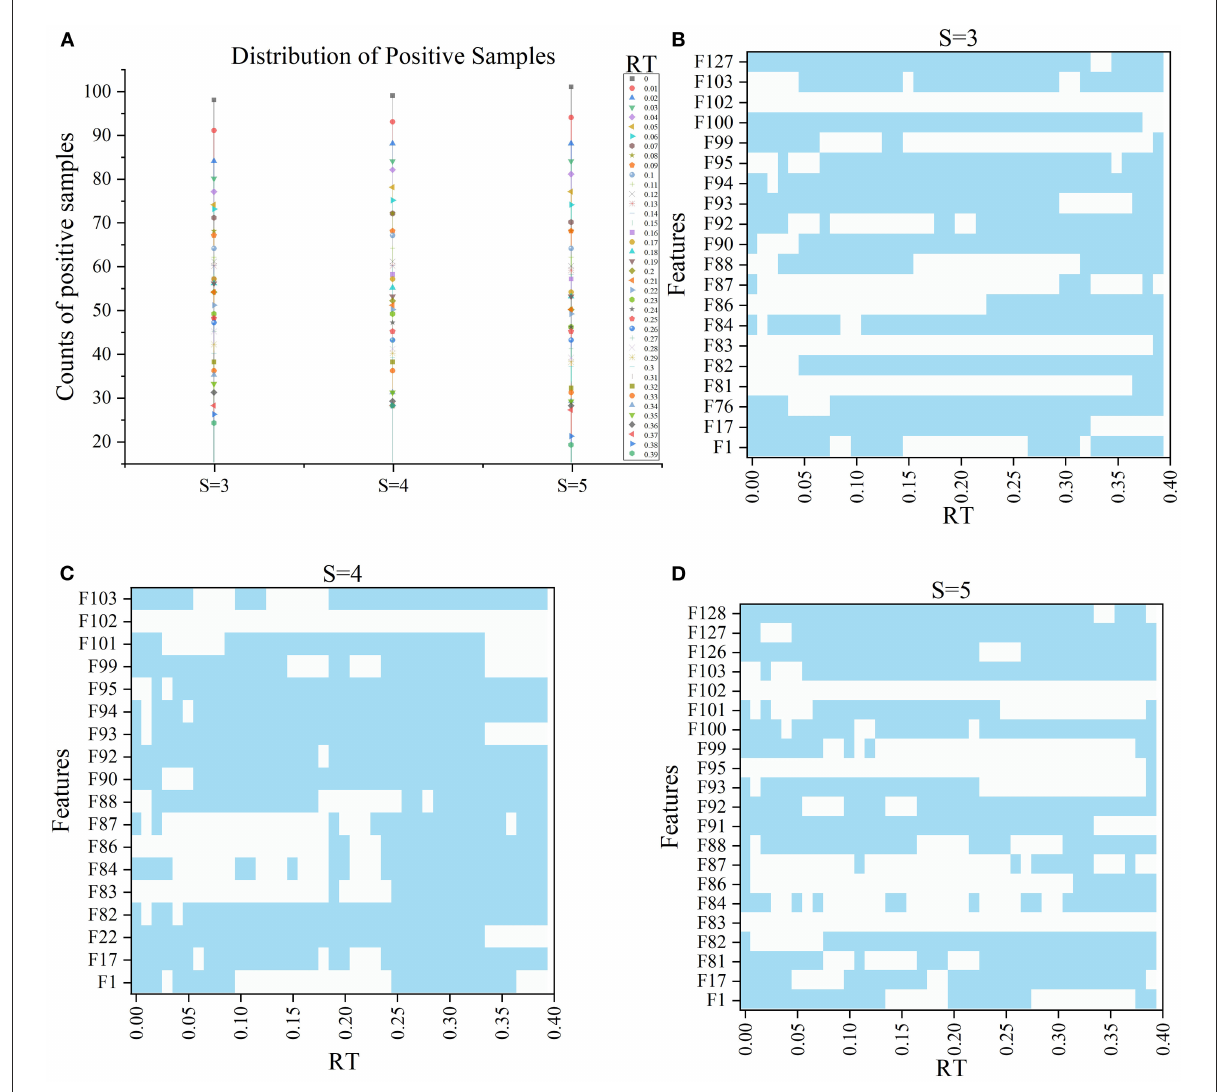
FIGURE5 The information of samples and F ′ RT_S . (A) Shows the distribution of positive samples with ranging S and RT and the features in F ′ RT_S , and (B–D) show the selected features under different RT values when S = 3, 4, and 5 respectively, wherein blue indicates that the corresponding features are